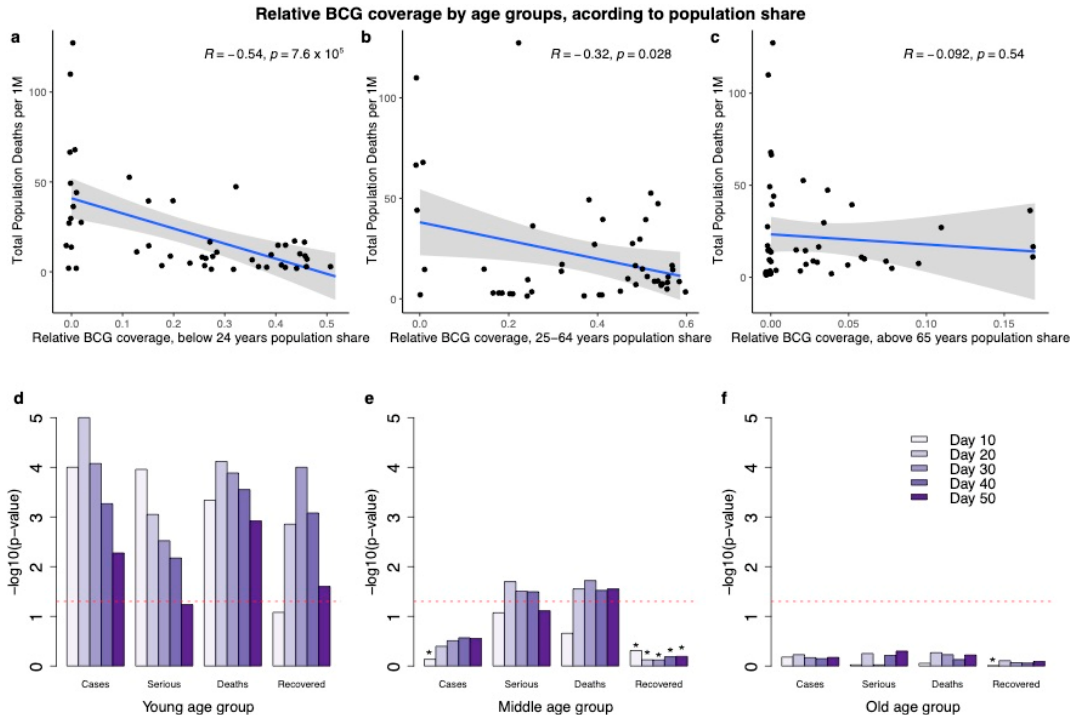
Figure 5. BCG coverage with respect to the DPM di ff erence among three age groups. All correlations ( a – c ) and statistical significance ( d – f ) were measured following the DPM ≥ 0.5 alignment key date. Relative BCG coverage is partitioned to three age groups, weighted by population share: (a) young (0–24 years), (b) middle age (25–64 years) and (c) old age group ( > 65 years). Notice that data points in panels a–c were slightly moved horizontally to help distinguish overlapping symbols. The histogram (d–f) shows the statistical significance of the correlation of BCG years of administration for the 4 di ff erent COVID-19 outcomes according to the 3 age groups marked as: young (d) middle age (e) and elderly (f). Days from the key alignment date are colored from light to dark purple (10 to 50 days). The statistical significance is shown as − log10 ( p -value), the dashed red line indicates p -value of 0.05. Asterisk represents the outcome with a positive correlation. All results with a positive correlation, marked by asterisks (*), are insignificant.